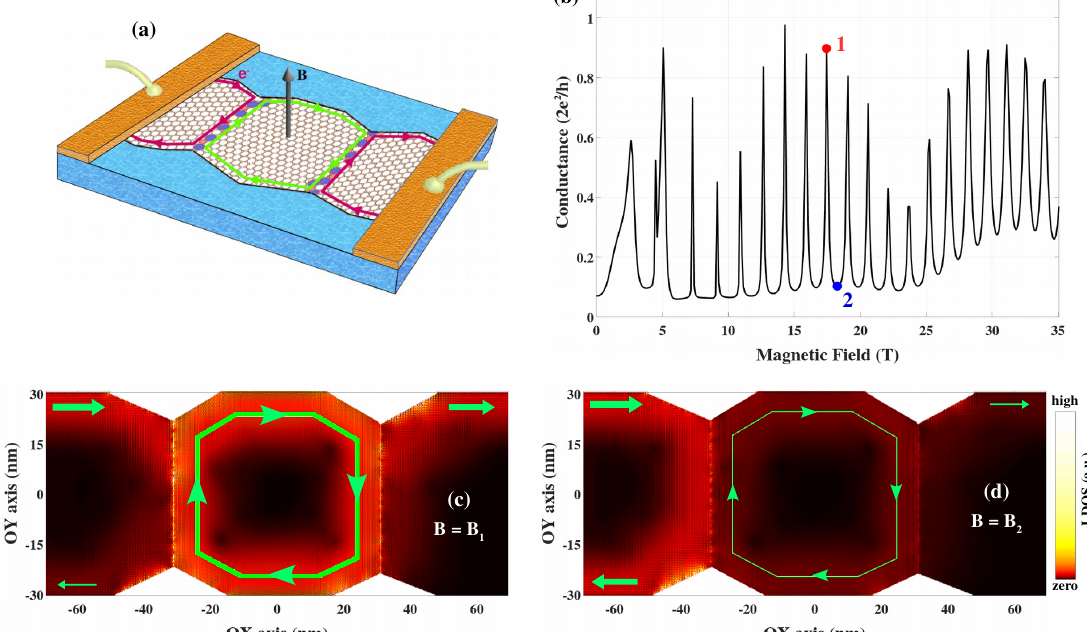
Figure 3. Aharonov–Bohm interferences in polycrystalline graphene in the quantum Hall regime: ( a ) Schematic of considered systems, ( b ) computed conductance as a function of the magnetic field, and ( c , d ) images of the local density of left-injected electronic states at magnetic fields ( c ) B 1 (conductance peak), marked in red in ( b , d ) B 2 (conductance valley) marked in blue in ( b ). Reprinted and adapted with permission from reference